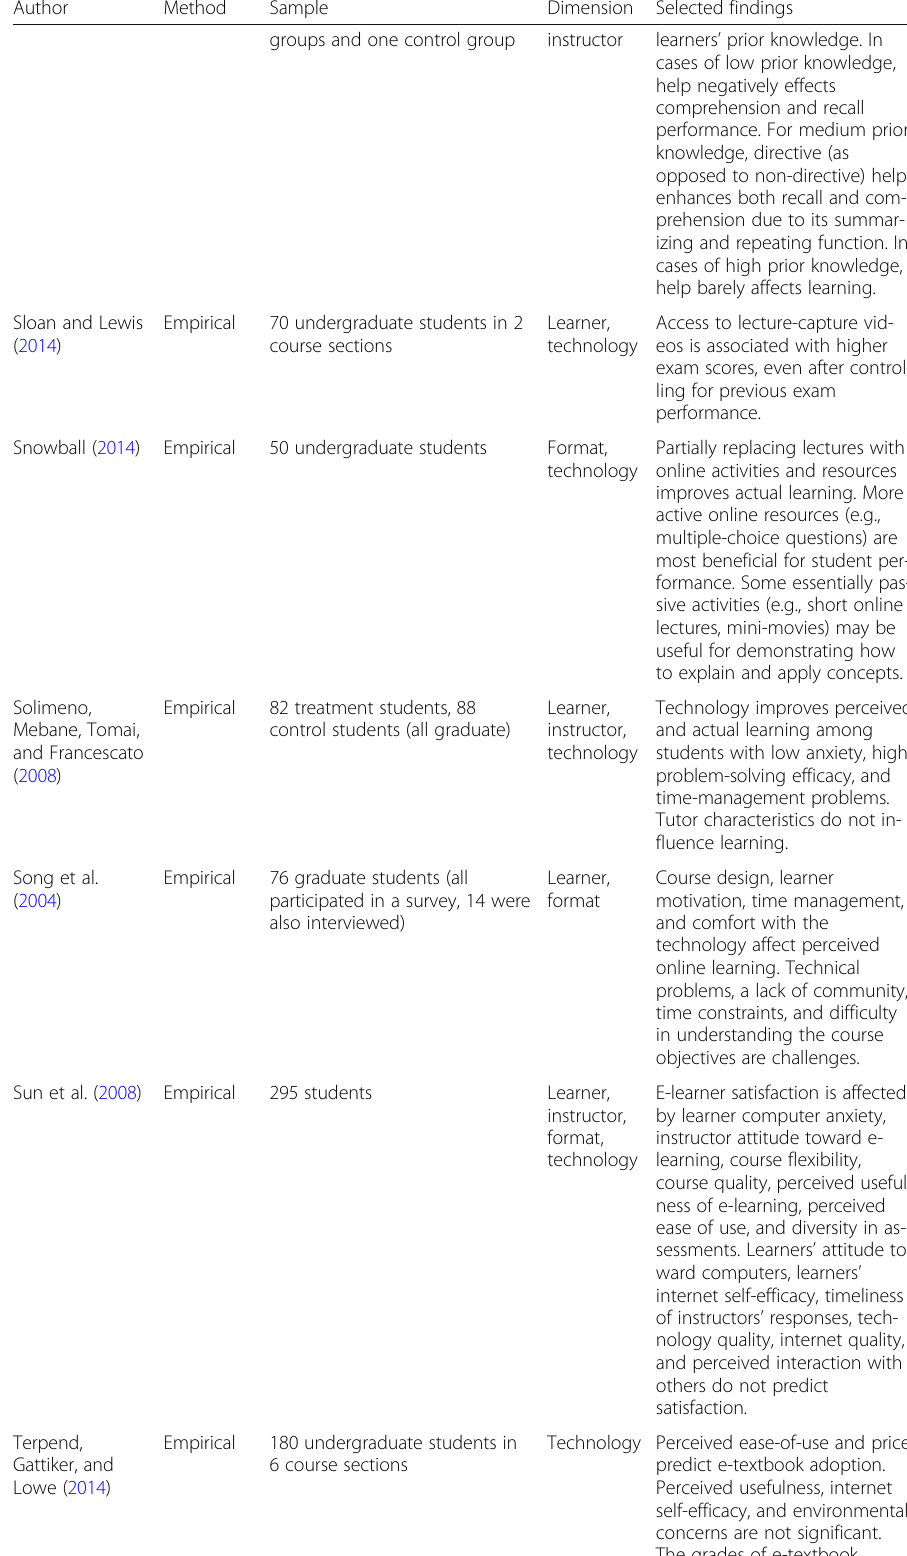
Table 1 Overview of Findings from the Extant Literature